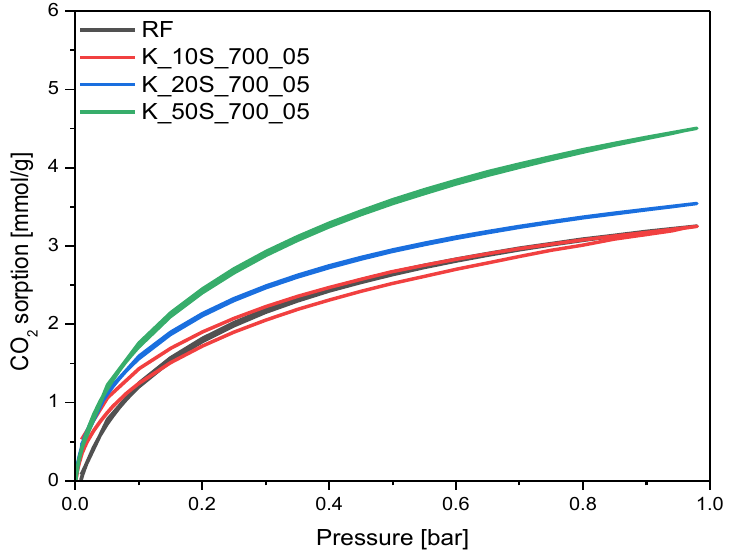
Figure 11. CO 2 sorption isotherms at 0 ° C of the samples activated using solid-based method with different KOH content.